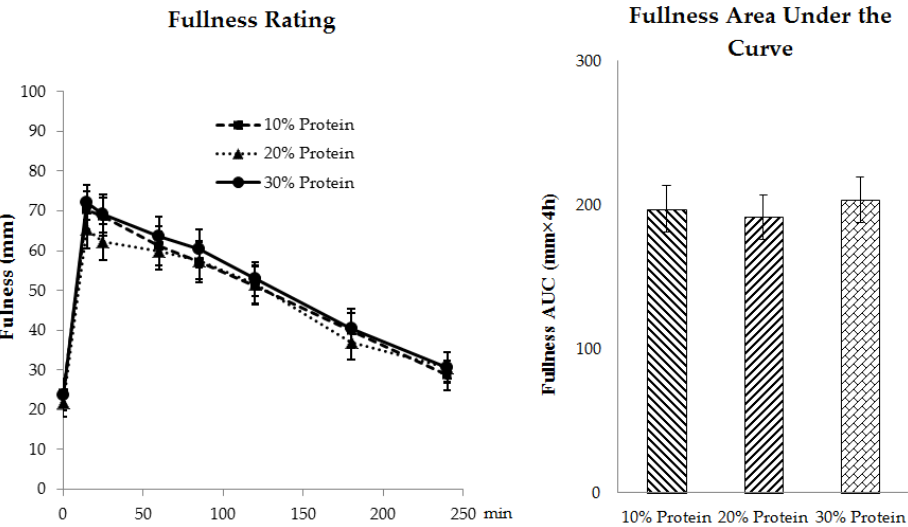
Figure 6. Postprandial ratings of fullness at the end of each 4-week period (day 28) independent of protein source